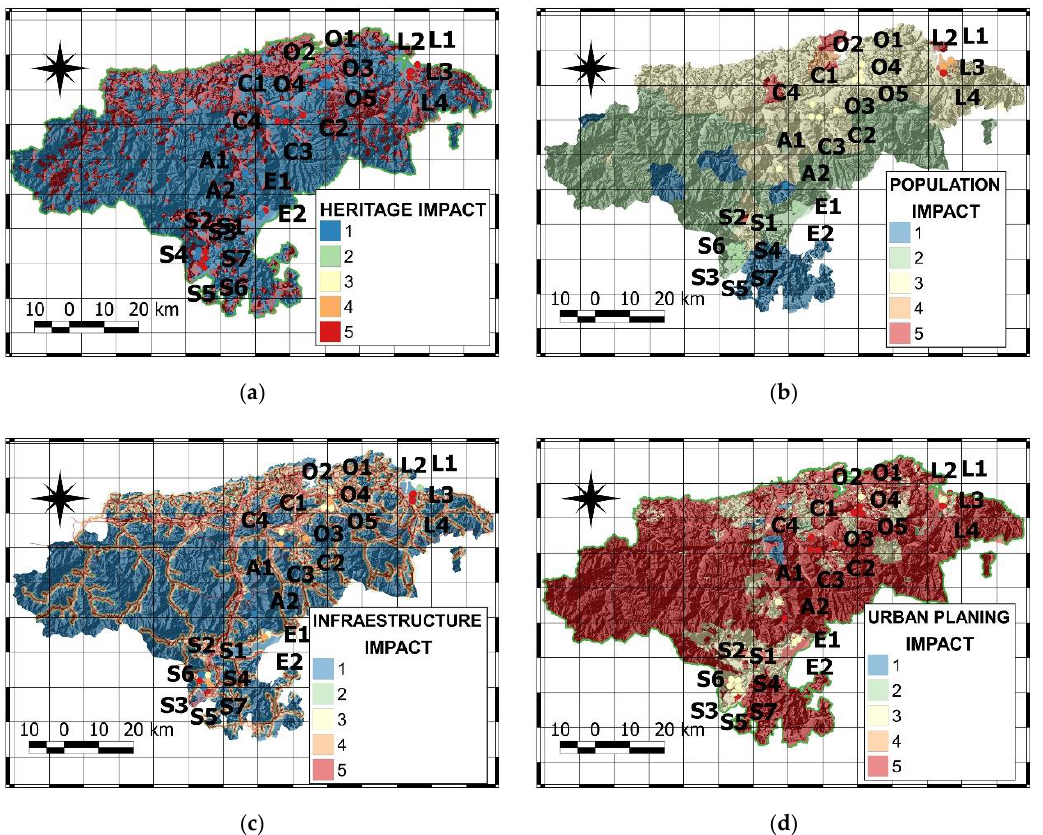
Figure 4. Maps of impacts according to components: ( a ) heritage, ( b ) population, ( c ) infrastructures and ( d ) urban